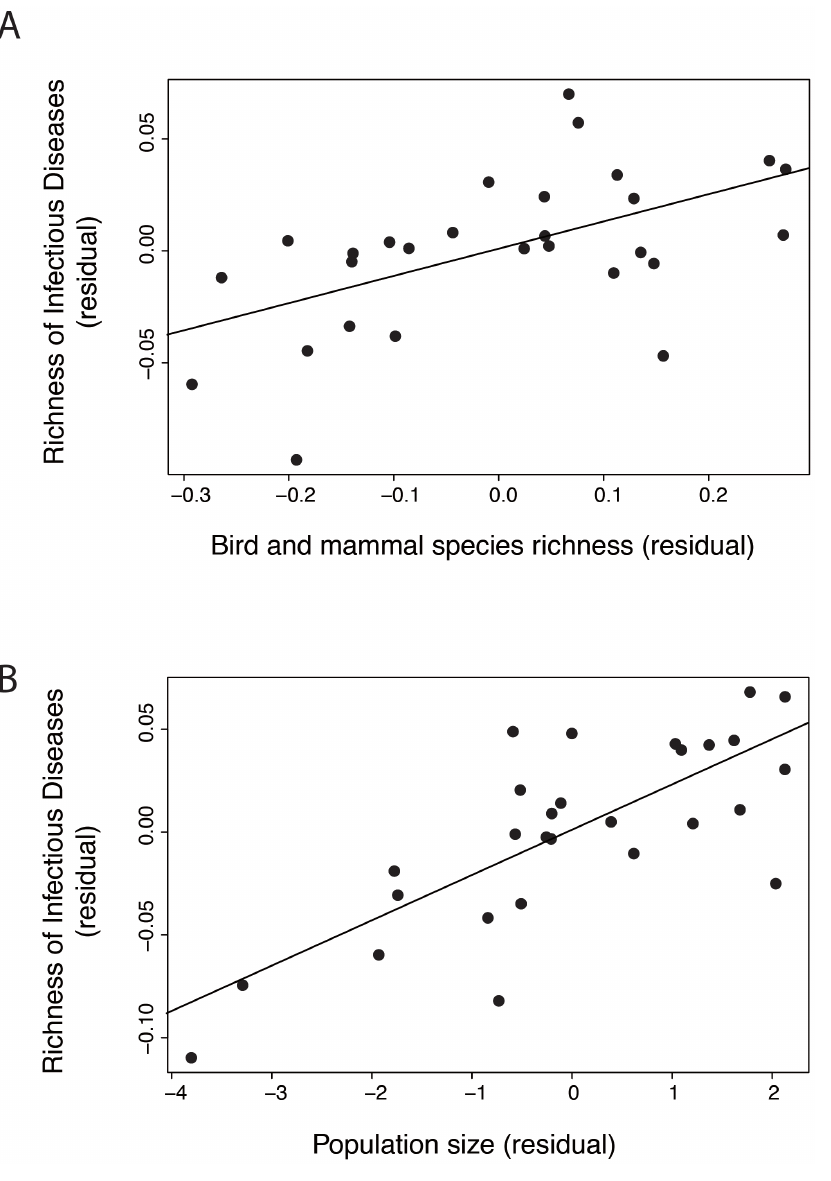
Figure 2. Partial relationships (partial correlation using residuals of the best models selected in Table 1) between the richness of infectious diseases and (A) the richness of bird and mammal species and (B) population size (partial correlation of the best GLM selected in Table 1).